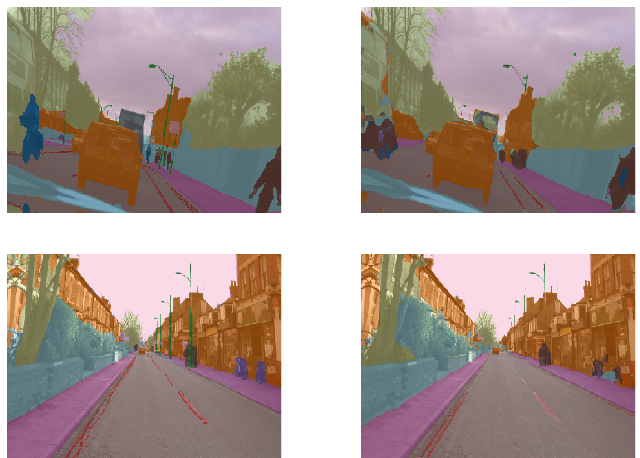
Figure 5. For a segmentation task, the ground-truth mask is laid at the right of the predicted mask.